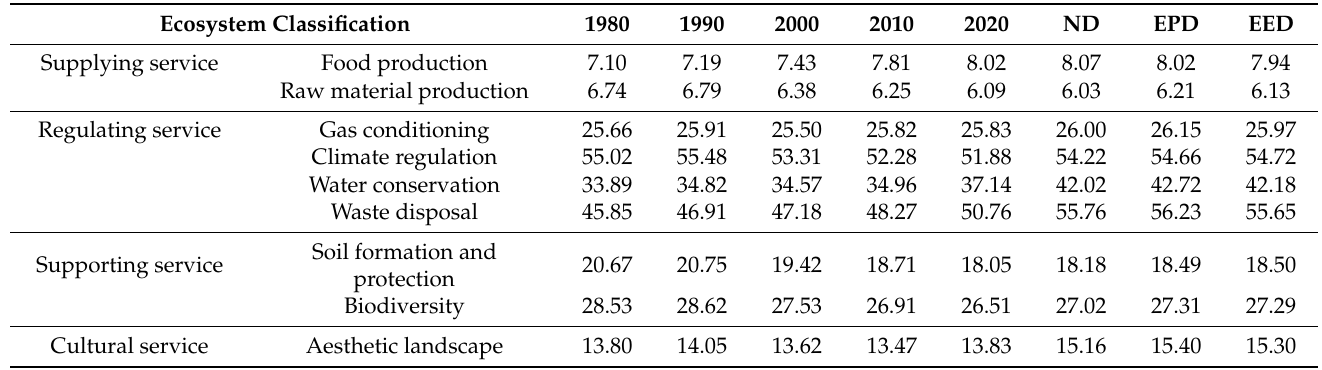
Table 3. ESV in the Manas River Basin during 1980–2030 ( × 10 8